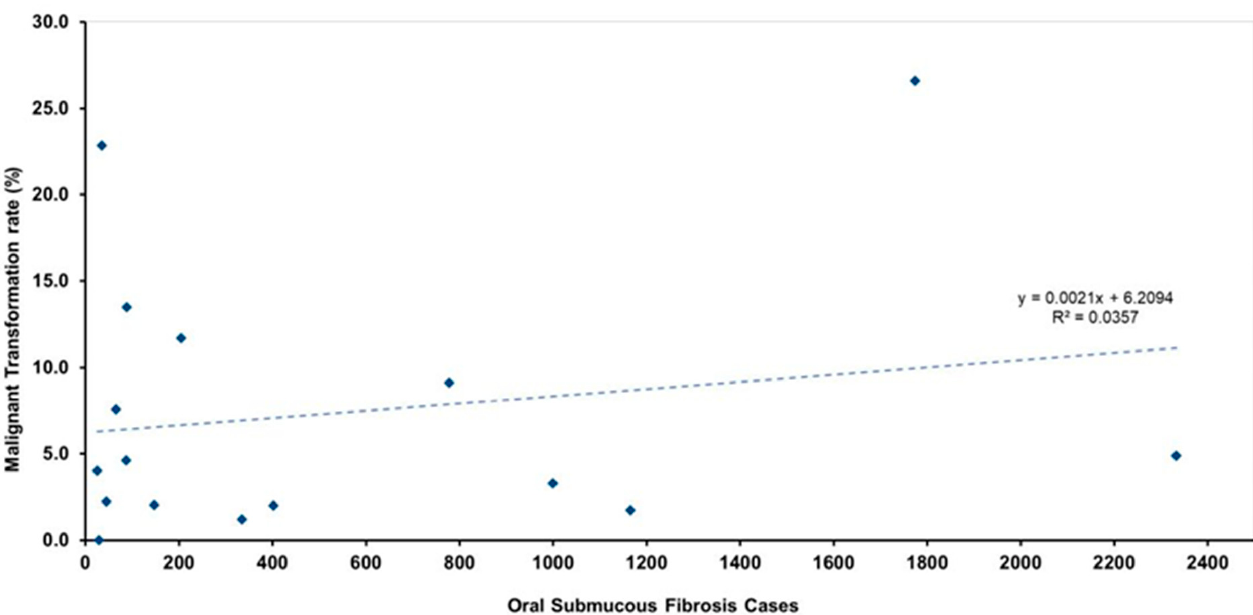
Figure 3. Comparison of cohort size and rate of malignant transformation of OSF as reported per study. Linear regression analysis for all data sets.